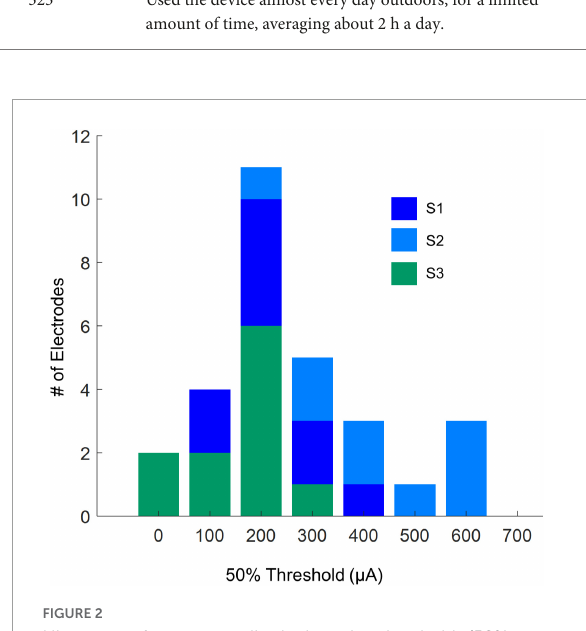
FIGURE2 Histogram of current amplitude detection thresholds (50% detection